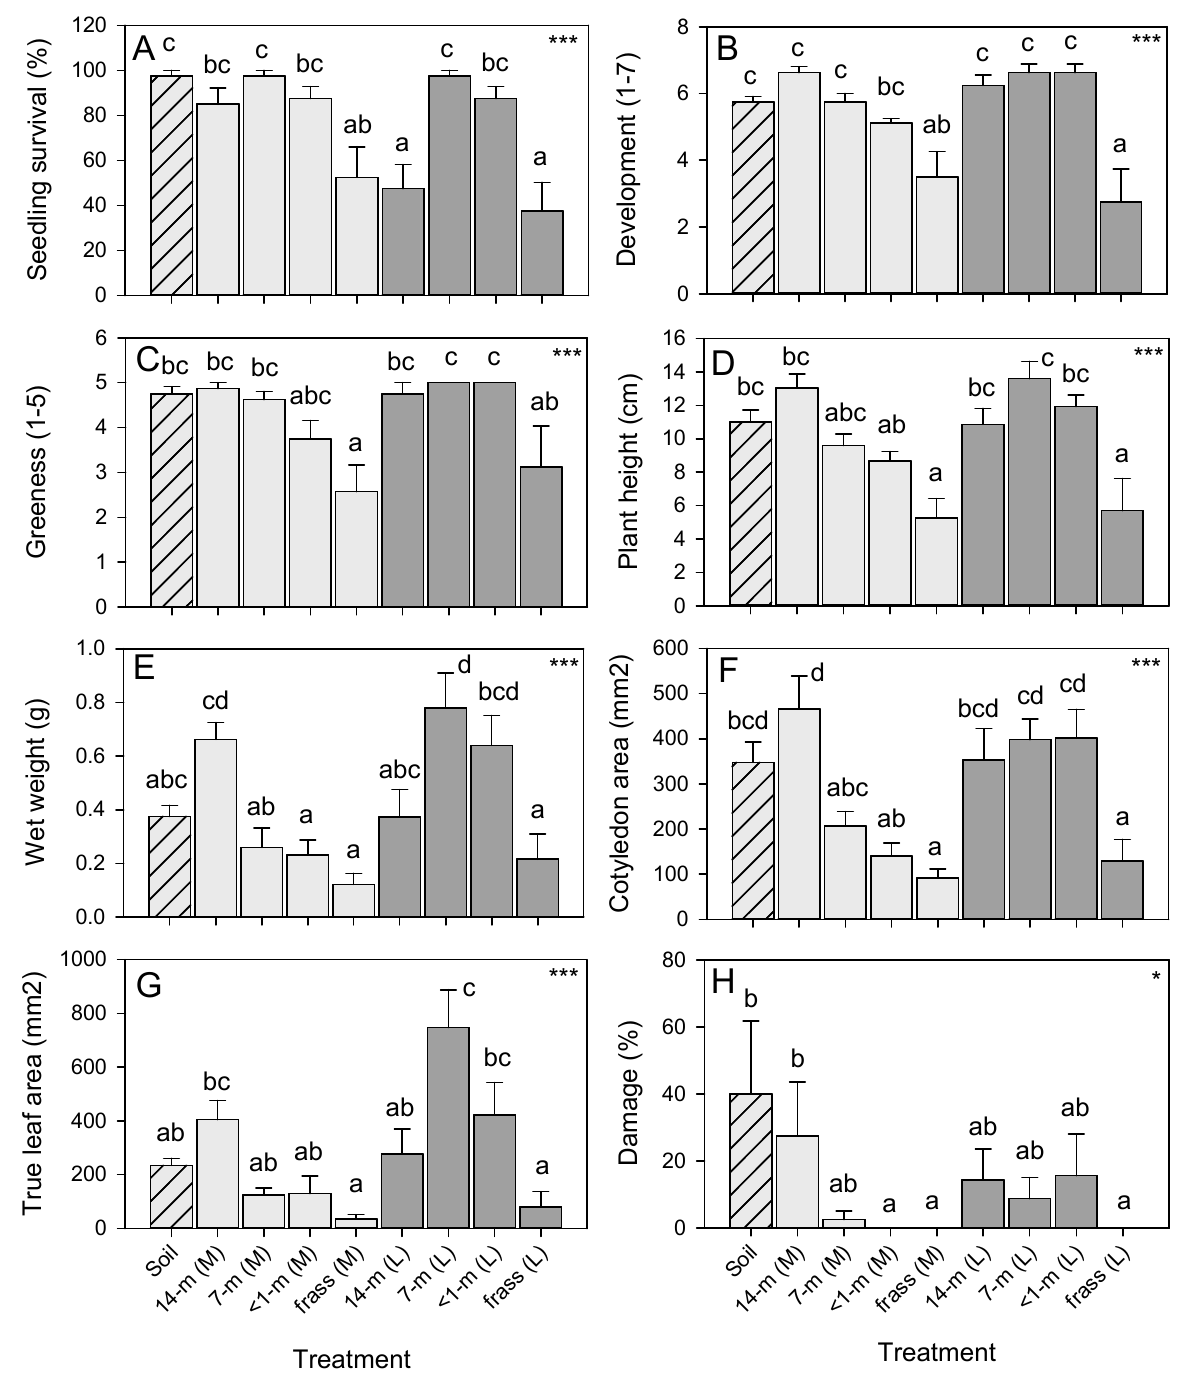
Figure 3. Growth of radish plants in pots with amendments applied as mixed (M = light gray) or layered (L = dark gray) with soil. Control pots with unamended soil (Soil) are indicated by the hatched bars on each plot. Amendments included 14-, 7-, and < 1-month-old SCG, as well as frass from BSF larvae reared on SCG. Measured parameters are presented as ( A ) seedling-survival, ( B ) growth stage (related to the number of leaves), ( C ) greenness, ( D ) plant height, ( E ) wet weight of plant, ( F ) cotyledon leaf area, ( G ) leaf area of true leaves, and ( H ) damage to plants during outdoor exposure for 10 days after the experiment. Results of GLMs are indicated as * = p < 0.05 and *** = p < 0.001. Lowercase letters indicate homogenous substrate groups (Tukey p > 0.05). Standard errors are indicated (N =